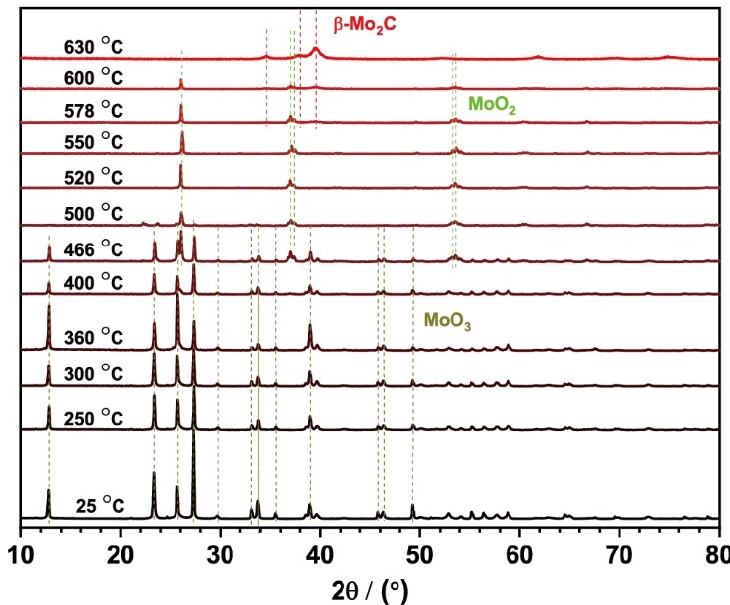
Figure 2. In situ XRD study of the carburization process of precursor 1.5Fe-MoO 3